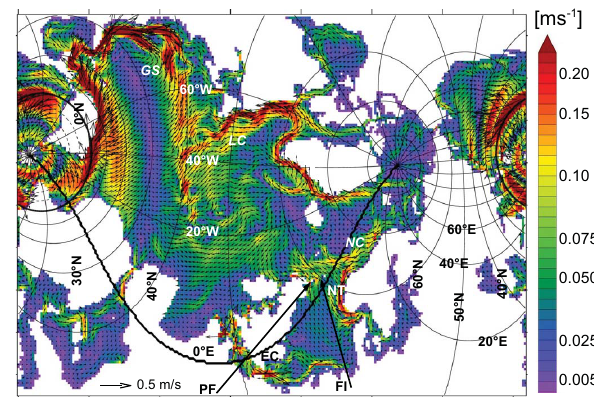
Fig. 1. Model domain. The zero meridian is indicated by the thick line. Also shown: surface circulation averaged over 1990–1999. Only every fourth vector is shown. EC is English Channel, NT is Norwegian Trench, PF is Pentland Firth, FI is Faire Island, NC is Norwegian Current, LC is Labrador Current, GS is Gulf